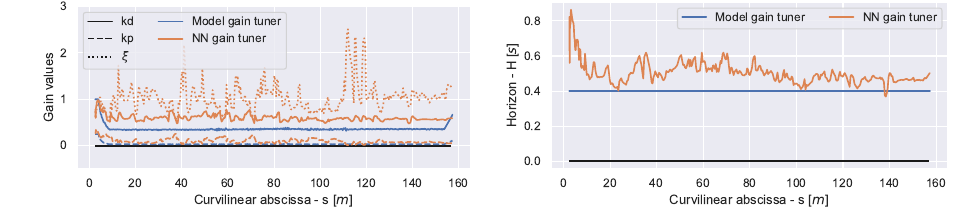
Figure 8. The gains ( left ) and the horizon ( right